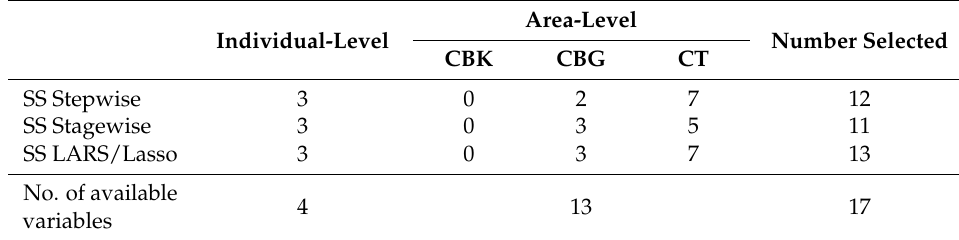
Table 2. Number of covariates selected at the individual-level and at each spatial scale (SS) by SS forward stepwise, forward stagewise, and LARS/lasso models. The last row lists the total number of possible variables at each data